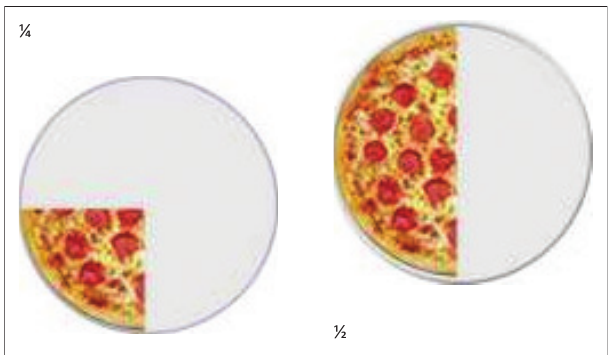
FIGURE 1: Fraction scheme.